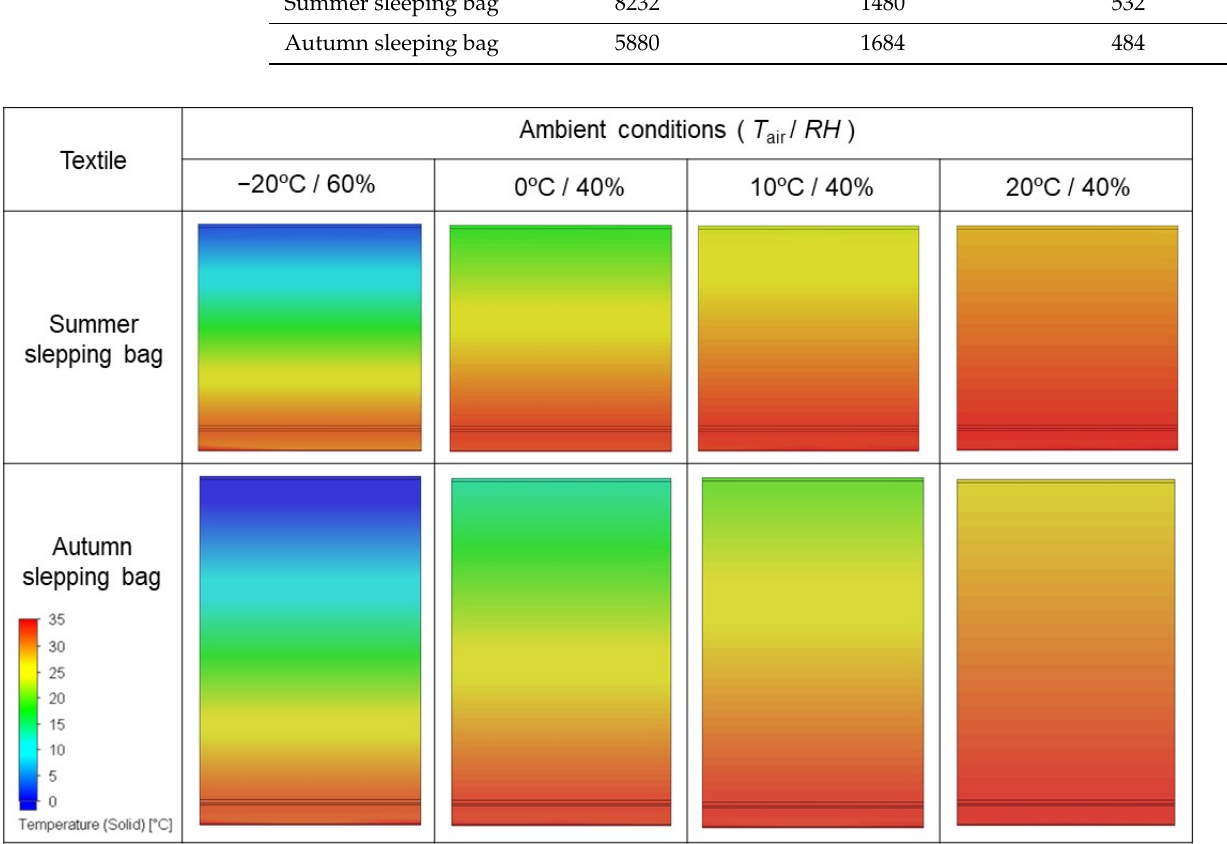
Figure 8. Summary of average temperatures obtained during computer simulations in individual zones of the tested sleeping bags.